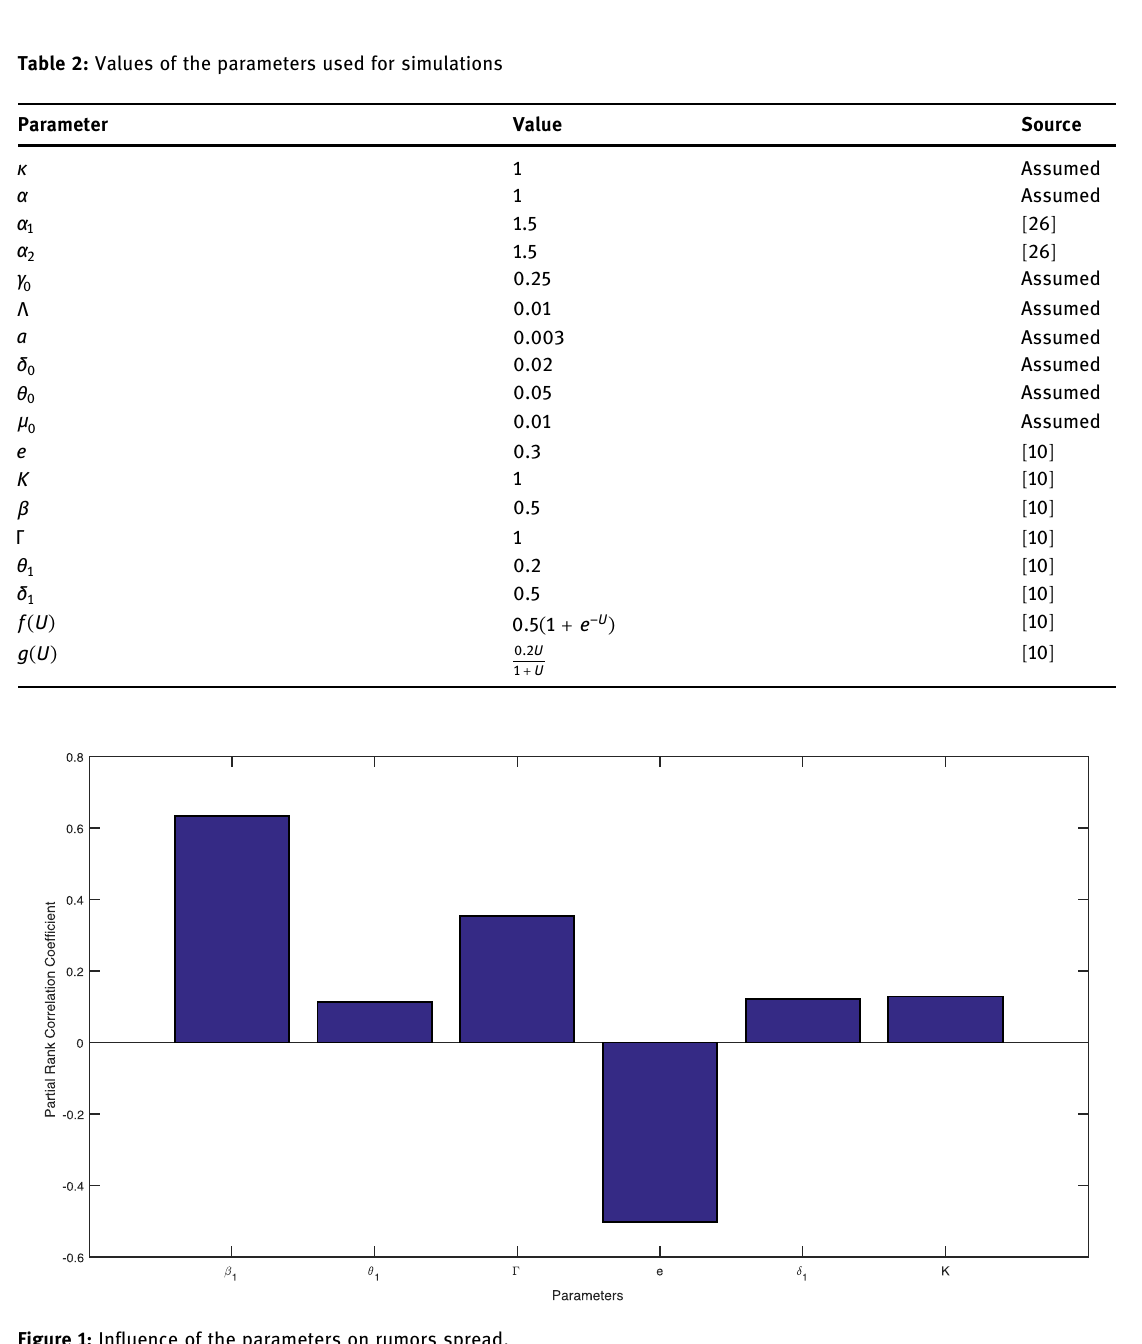
Figure 1: In fl uence of the parameters on rumors